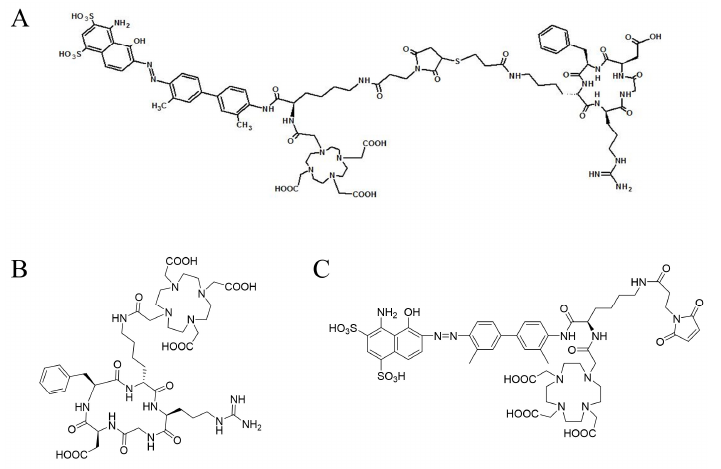
Figure 1. The structural formula of DOTA-EB-cRGDfK, DOTA-cRGDfK, and DOTA-EB. Molecular weights are 1900, 990.11, 1208.28, respectively.